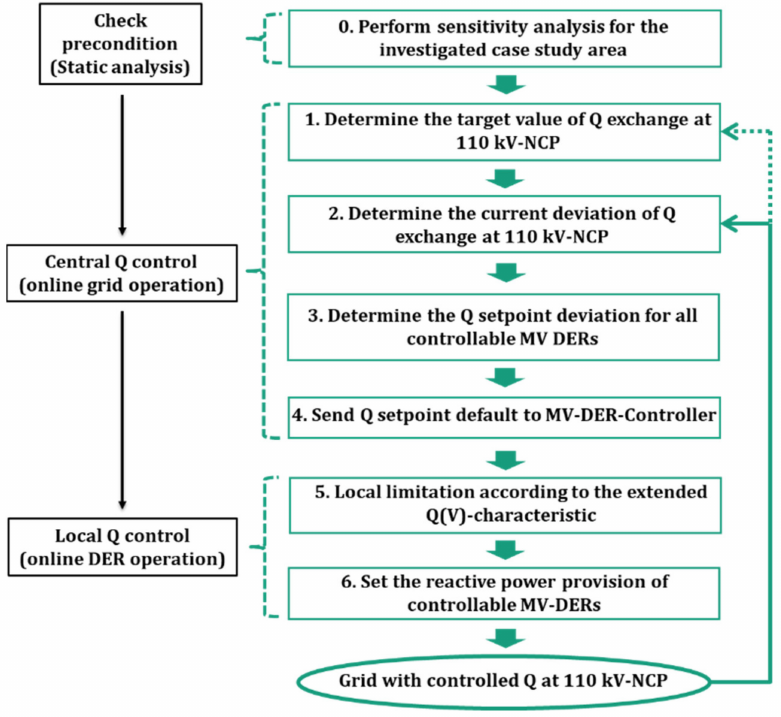
Figure 2. Flowchart of detailed control